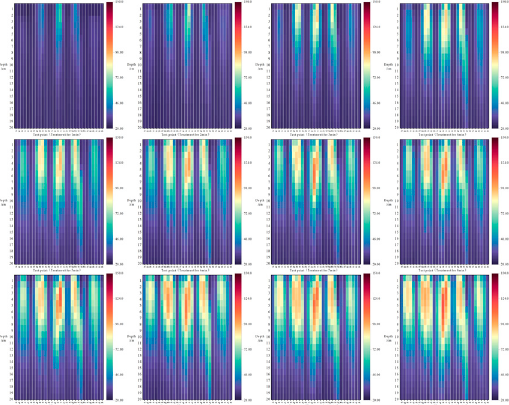
Figure 19. Heatmap of the internal temperature of 15% black soil under microwave irradiation.